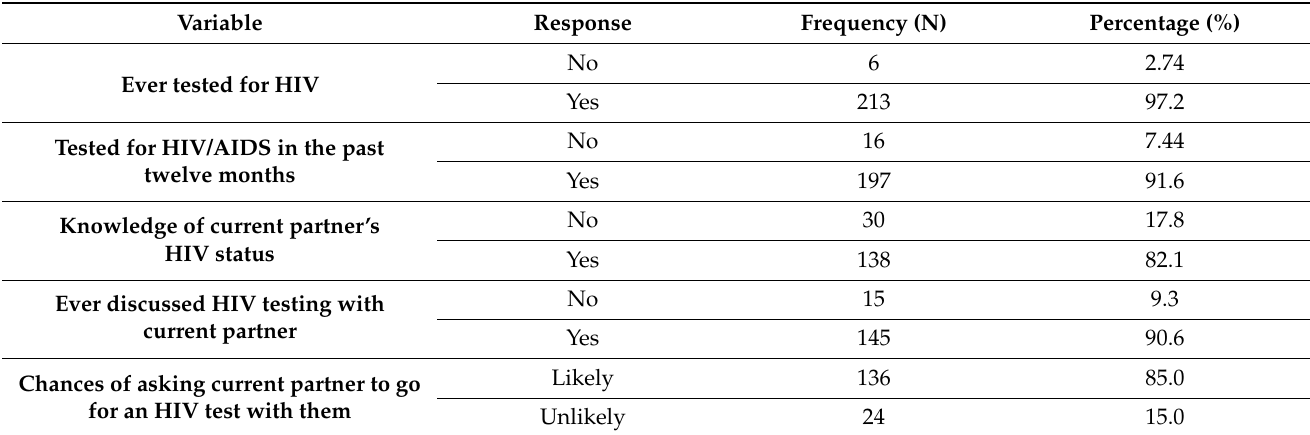
Table 8. HIV testing practices (n = 219) of